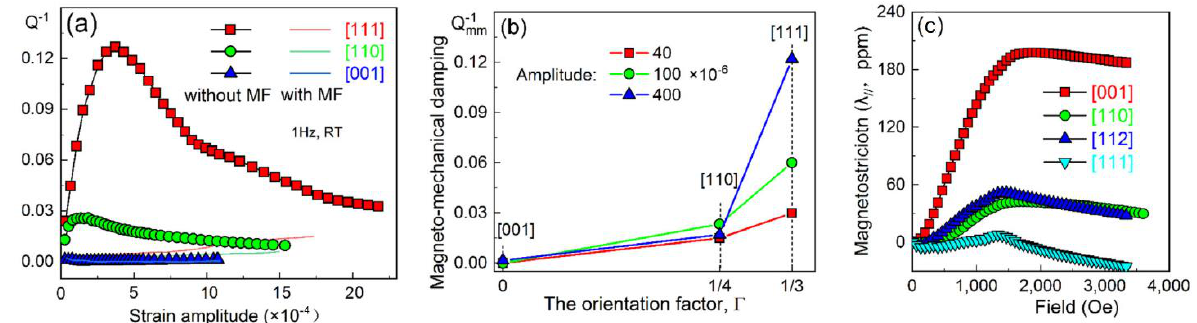
Figure 15. ( a ) the variation of damping capacity with strain amplitude for [001]-, [110]-, and [111]- oriented single crystals at RT at 1 Hz; ( b ) magnetomechanical damping against the orientation factor Г at strain amplitudes of 0.4 × 10 −4 , 1 × 10 −4 , and 4 × 10 −4 ; ( c ) Magnetostrictive curves of [001]-, [110]-, [111]-, and [112]-oriented single crystal samples [56].